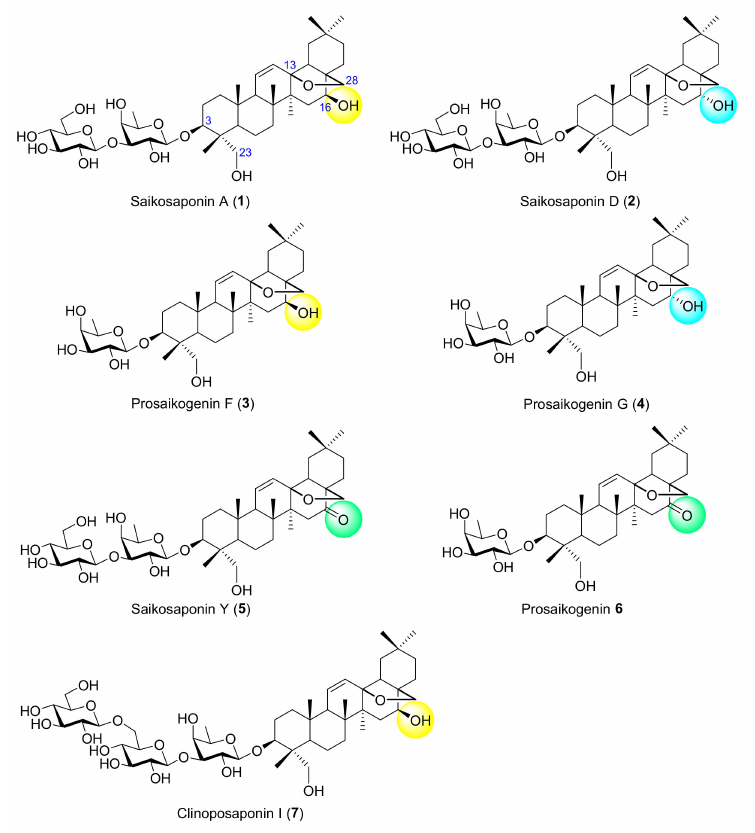
Figure 1. Saikosaponin A ( 1 ), D ( 2 ), and congeners ( 3 – 7